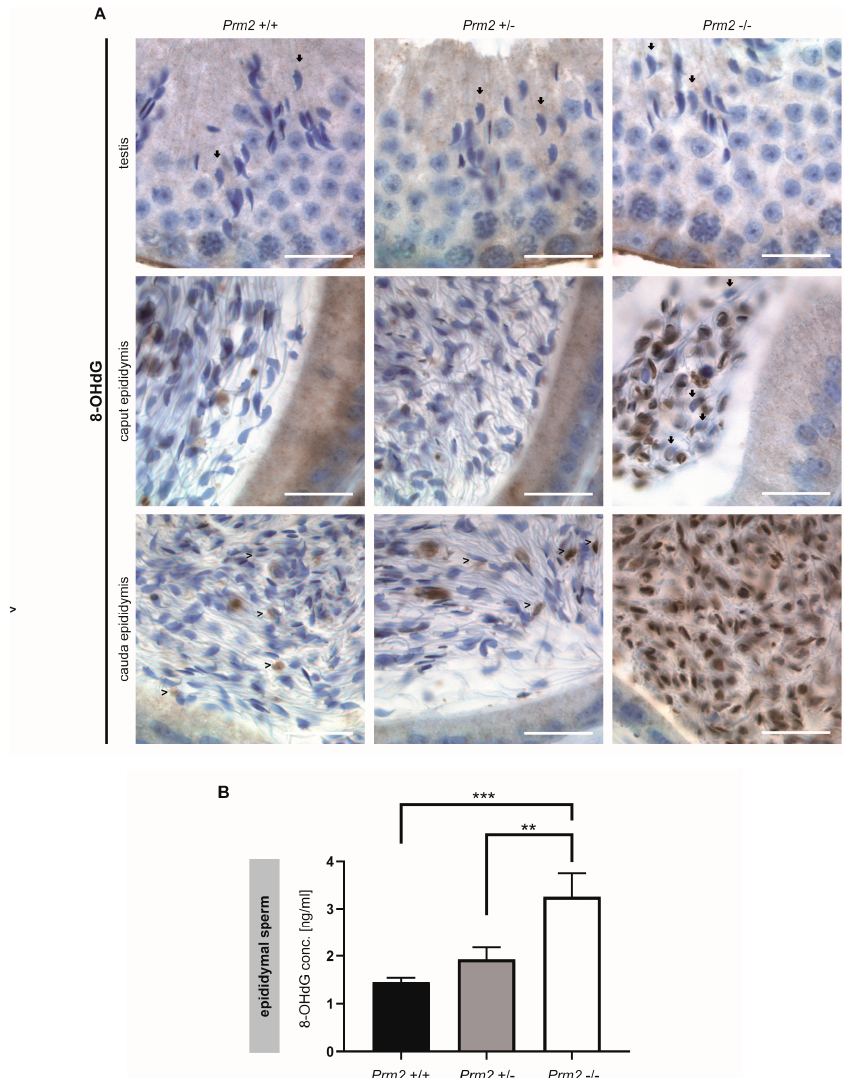
Figure 4. Oxidative stress causes DNA damage in Prm2 -deficient sperm during epididymal maturation. ( A ) Representative immunohistochemical staining ( n = 3) against 8-OHdG as a biomarker for oxidative DNA damage. Staining of testicular (top row), caput epididymal (middle row) and cauda epididymal (bottom row) tissue sections from Prm2 +/+ (left column), Prm2 +/ − (middle column) and Prm2 - / - (right column) animals is shown. Note increasing oxidative damage in Prm2 -deficient sperm during epididymal transit. Arrows highlight 8-OHdG negative spermatids / sperm, arrowheads 8-OHdG positive cells. Scale bar: 20 µ m. ( B ) Quantification of 8-OHdG levels in epididymal sperm DNA from Prm2 +/+ , Prm2 +/ − and Prm2 − / − males by ELISA (n = 5; statistical significance was determined by non-parametric Kruskal-Wallis-Test, ** p = 0.0002; *** p < 0.0001).